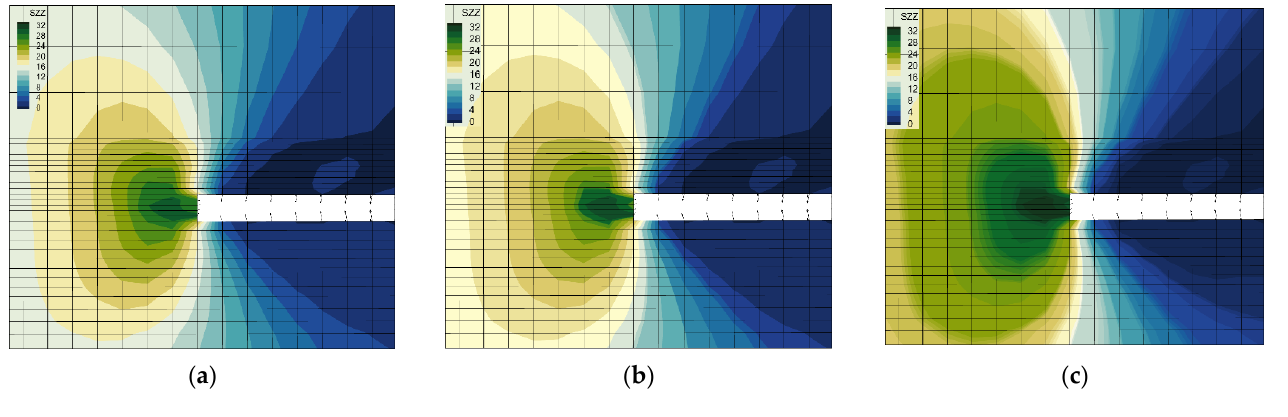
Figure 7. Evolutionary law of the stress field of surrounding rock with different basic top-coal thickness-to-span ratios in the advancing direction of a stope. ( a ) Thickness-to-span ratio less than 0.5. ( b ) Thickness-to-span ratio of 0.5. ( c ) Thickness-to-span ratio greater than 0.5.